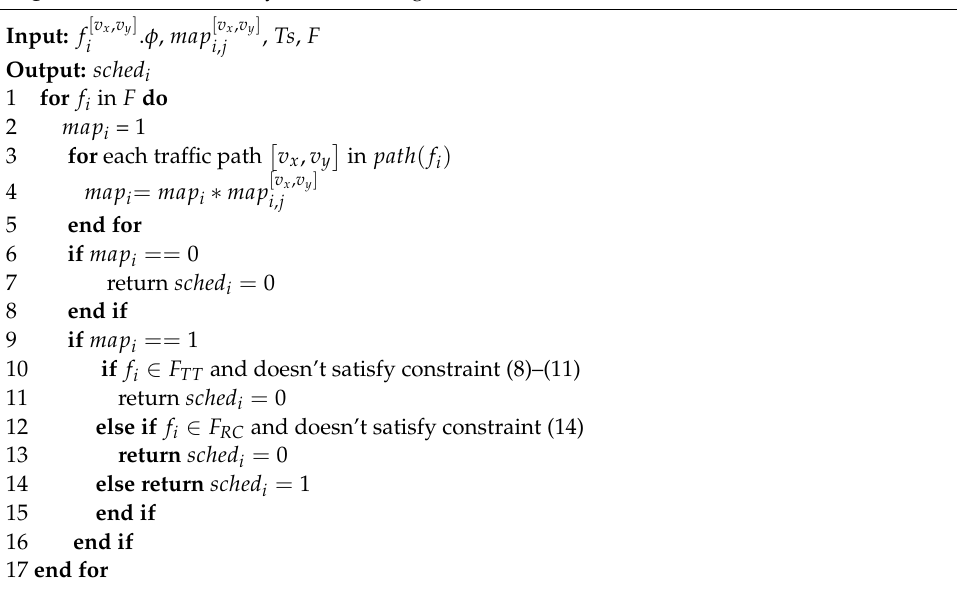
Algorithm 2 Schedulability evaluation